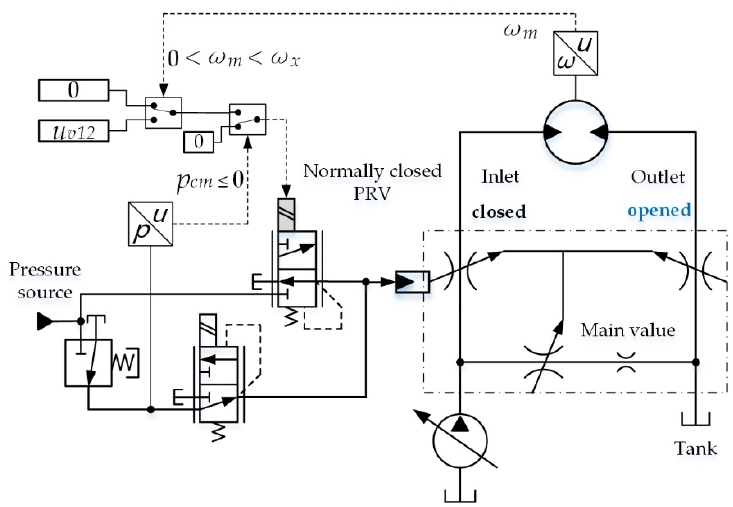
Figure 6. Schematic diagram of motor braking control.